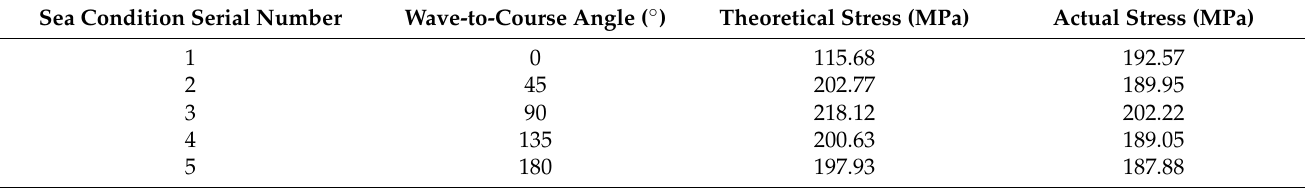
Table 9. Maximum stress of angle adjustment mechanism at initial adjustment angle of the tower (measuring point 2).